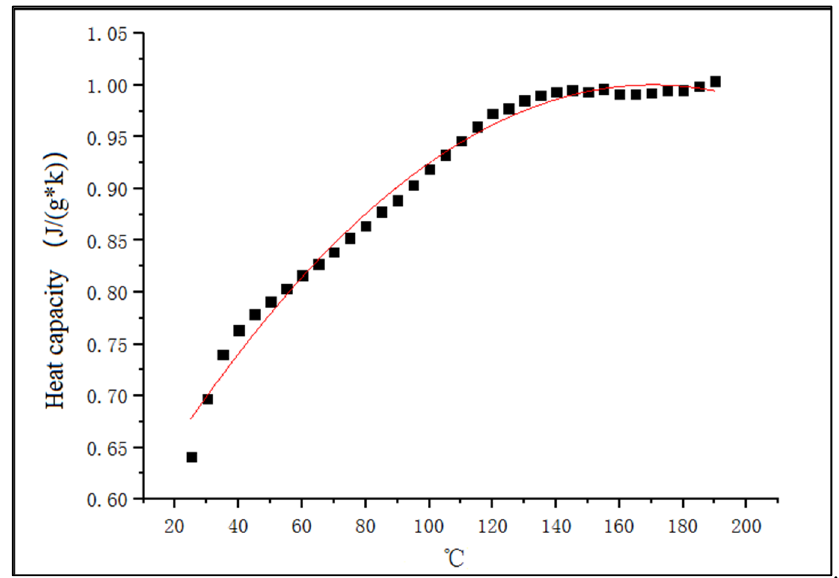
Figure 10. Plot of the relationship between temperature and specific heat capacity between 25 and 200 °C.